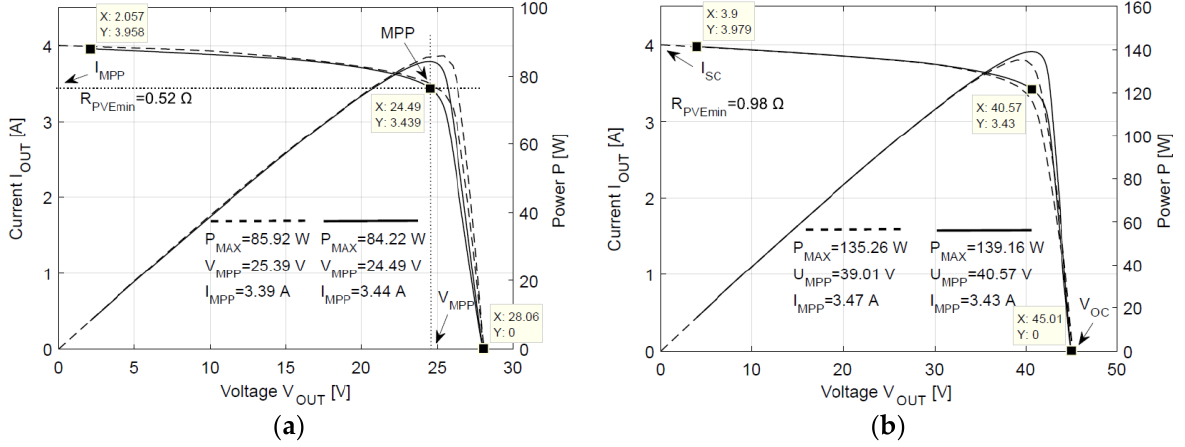
Figure 11. Simulation and measurement results for the output current range from 0 to 4 A: ( a ) For voltage V OUT equal 28 V, where V MPP and I MPP values are indicated; ( b ) For V OUT equal 48 V. The minimum values of the output resistance R PVEmin are specified. The location of important points is also shown: I SC , V OC , I MPP , V MPP .